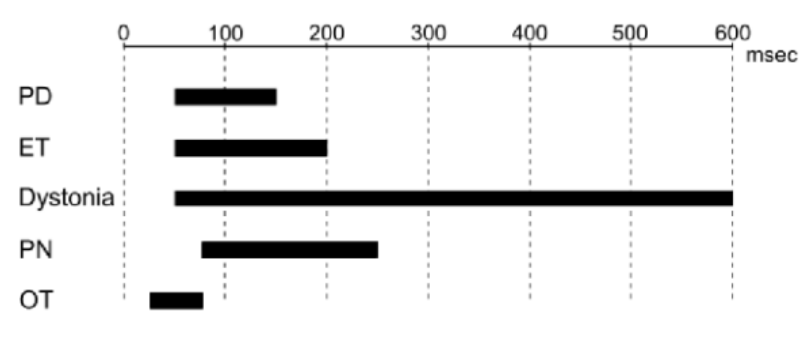
Figure 3. Duration of EMG bursts in forearm muscles in various neurological disorders associated with tremor. Abbreviations: PD: Parkinson’s disease, ET: essential tremor, PN: peripheral neuropathy, OT: orthostatic tremor. Adapted from Grimaldi and Manto,